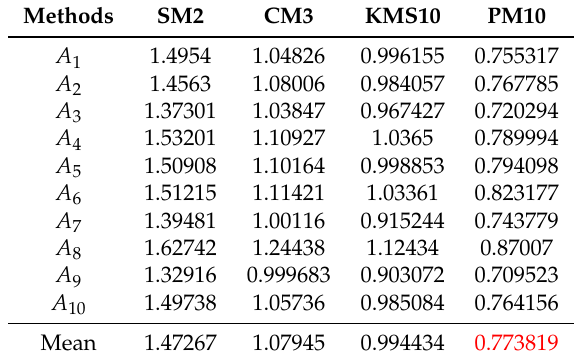
Table 2. Comparison based on the elapsed CPU time and its mean in Experiment 1.